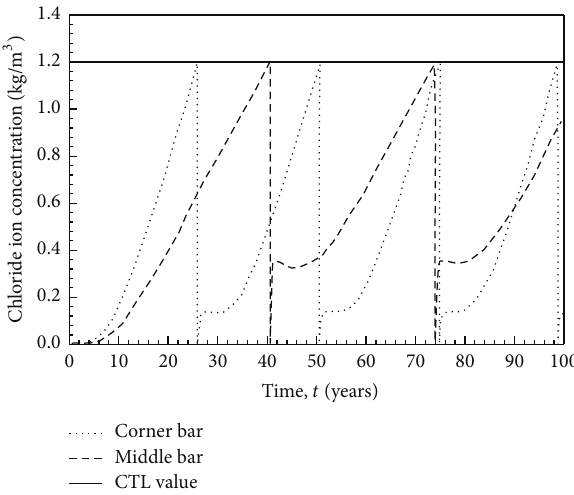
Figure 6: History of chloride ion concentration during the first 100 years of the column’s life. Comparison between repairs based on the middle steel bar and the corner steel